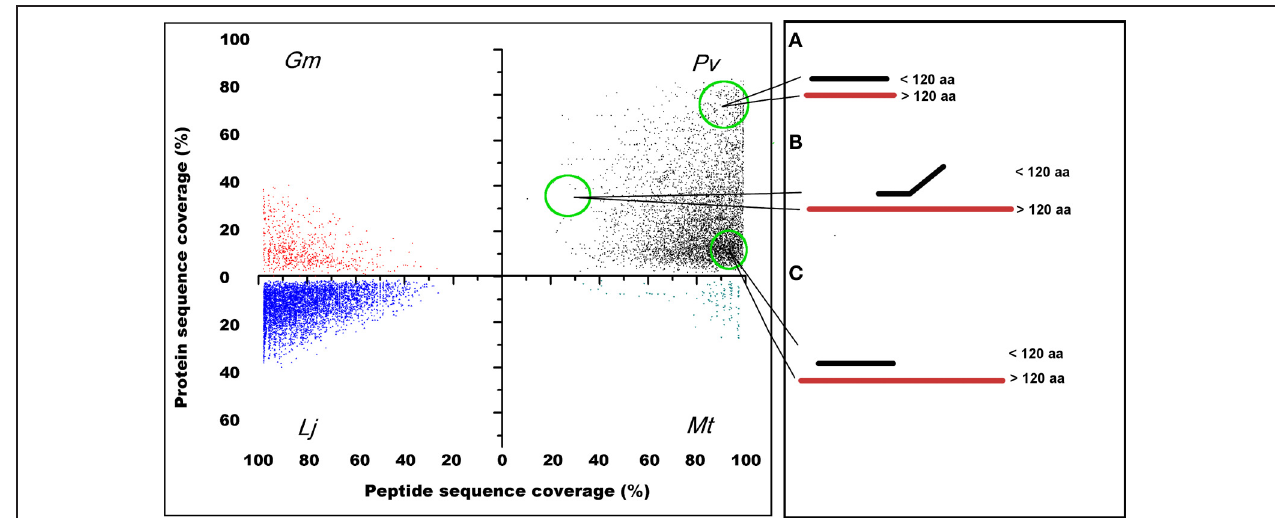
(A) illustrates the distribution pattern of sORFs in P. vulgaris that are identical in sequence to other small proteins (slightly larger than 120 aa); in (B) sORFs that share a domain with larger polypeptides are included; and in (C) sORFs that are completely equivalent to regions or domains found in larger proteins are indicated.